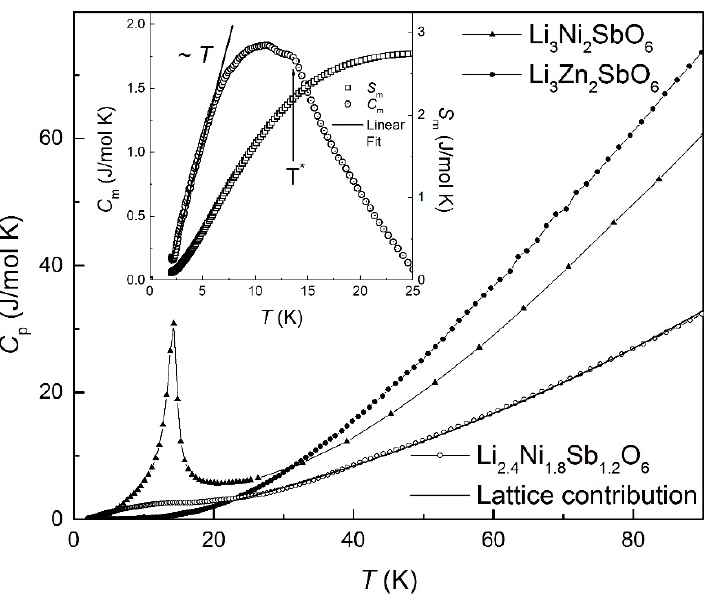
Figure 5. The temperature dependencies of specific heat C p (T) in zero magnetic field for Li 2.4 Ni 1.8 Sb 1.2 O 6 (open symbols) in comparison with undoped Li 3 Ni 2 SbO 6 (triangle symbols) and its isostructural non-magnetic analogue Li 3 Zn 2 SbO 6 (filled symbols). The solid line represents the lattice contribution of the specific heat. Inset: the magnetic specific heat C m (T) (open circles) and the magnetic entropy S m (T) (open